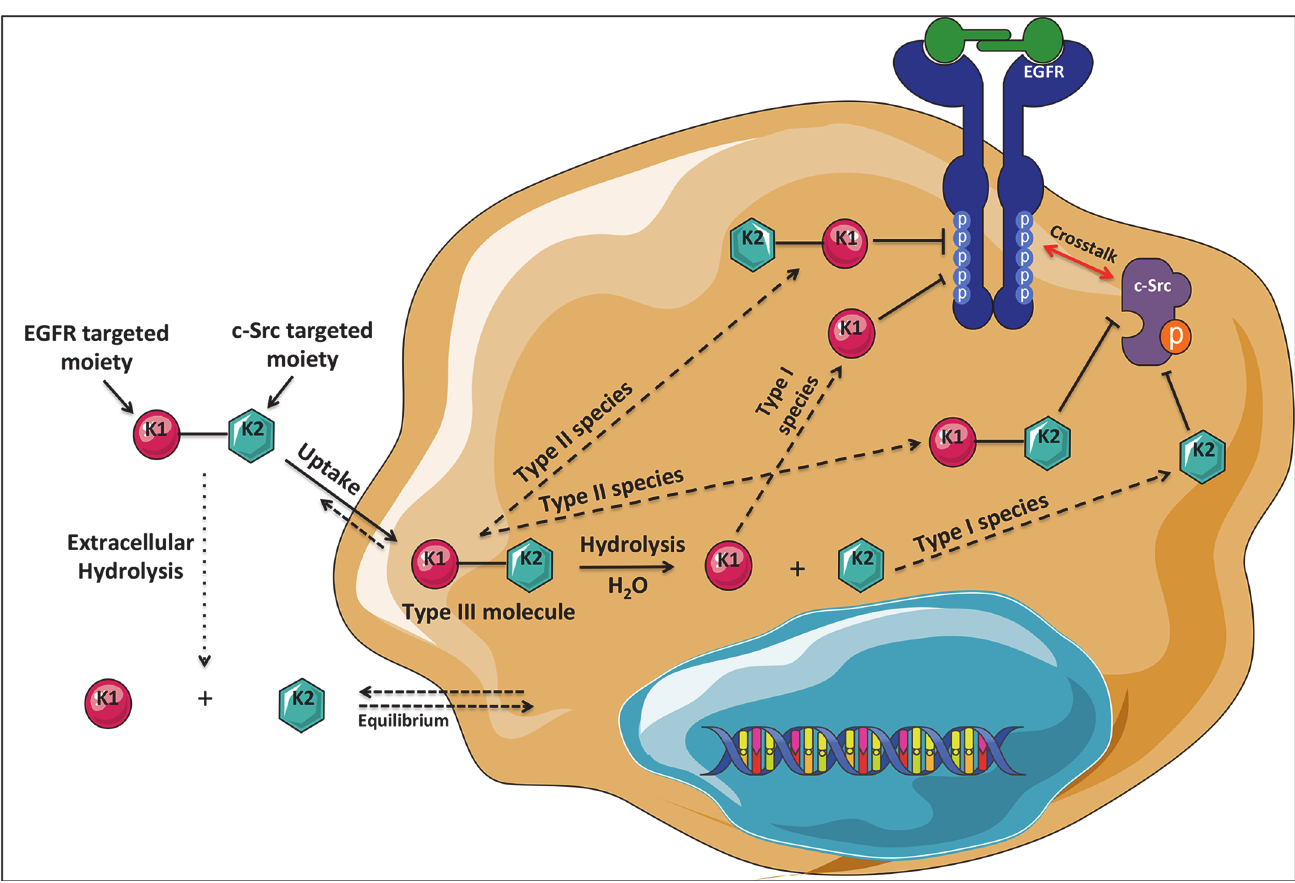
Fig 11. Schematic representation of type III combi-targeting mechanism with EGFR (K1) and c-Src (K2) as the kinase targets. Upon entering the cells, K1-K2 binds and inhibits its targets, EGFR and c-Src, both as an intact molecule and as a prodrug whose hydrolysis leads to the release of inhibitors of EGFR (K1) and c-Src (K2). The multiple bioactive species generated inside the cells inhibit both the targeted receptor and non-receptor tyrosine kinases, ultimately leading to inhibition of downstream signaling pathways associated with tumour growth and progression.